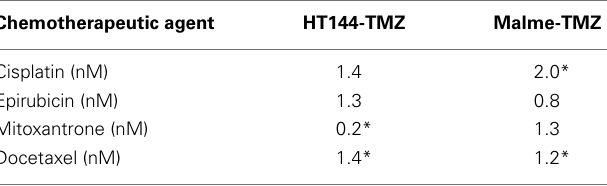
Table 6 | Fold resistance of HT144 and Malme-3M resistant variants compared with their parental cell lines .